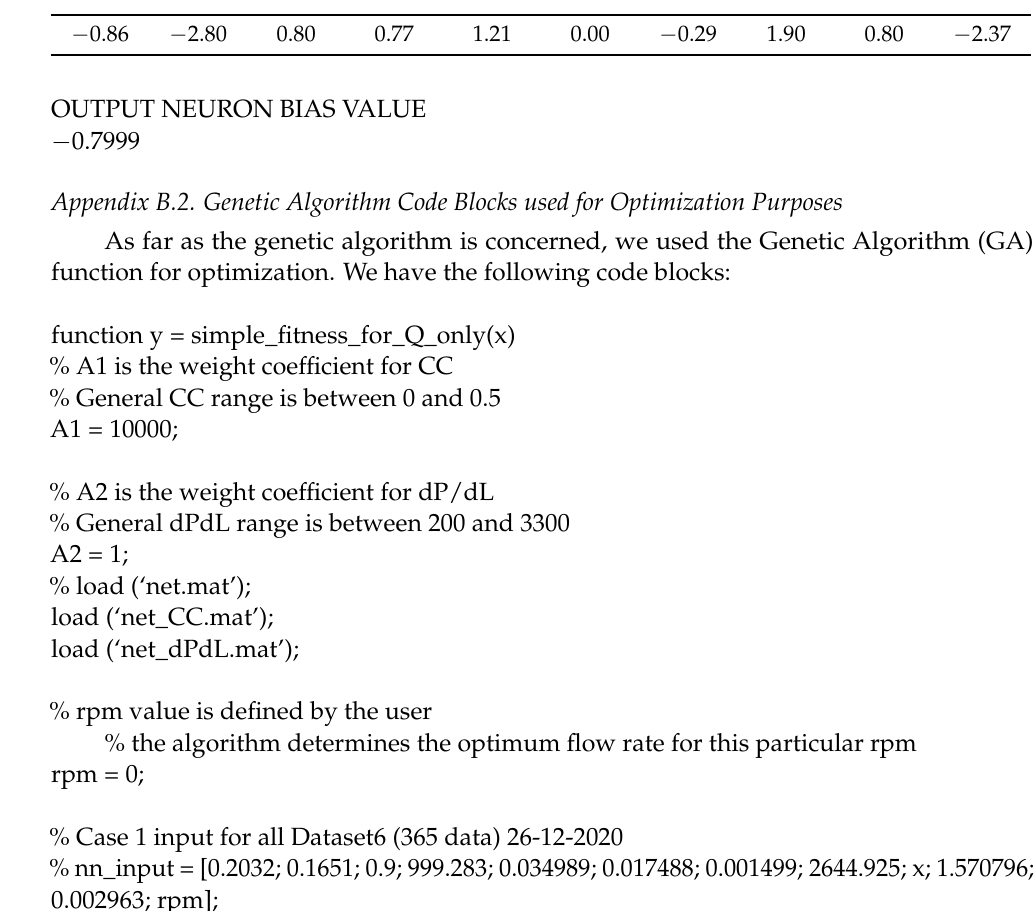
Table A6. Hidden neurons bias values (10 hidden